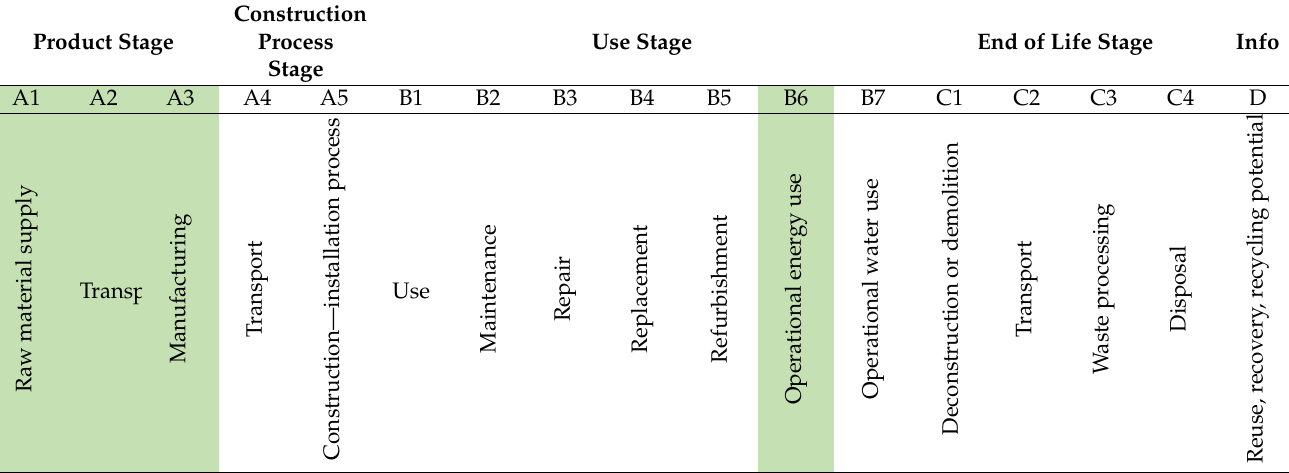
Table 1. Life cycle stages defined by CEN—EN 15,804 [18]. Stages A1–A3 and B6 marked in green were included in the research.